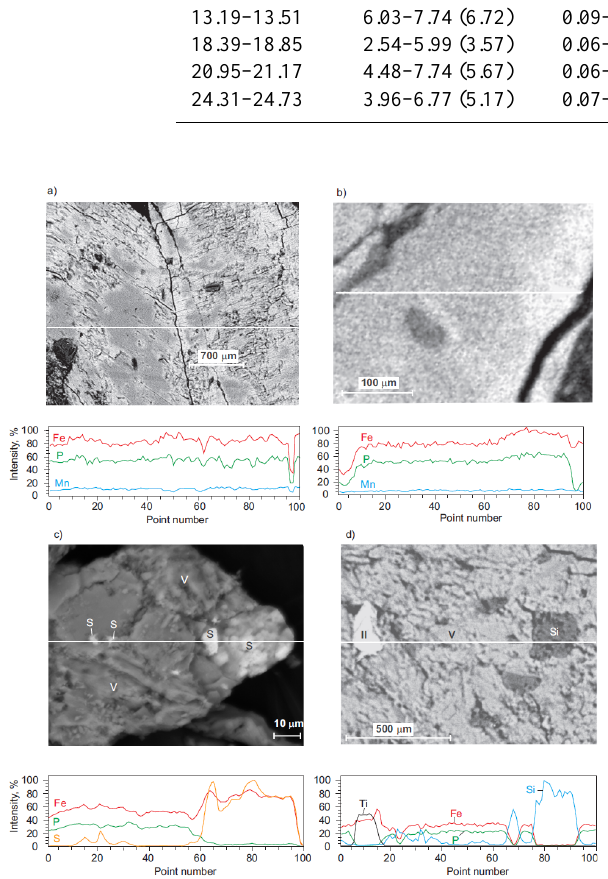
Fig. 5. Backscattered electron images of polished sections of vi- vianite nodules and energy dispersive spectroscopy. V – vivianite, S – sulfides, Il – ilmenite, Si – siliclastic.